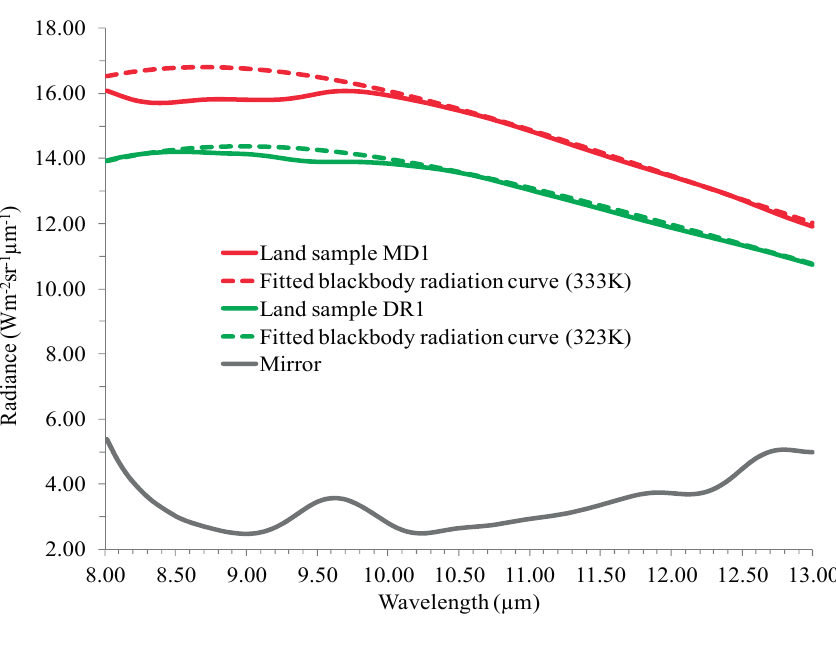
Figure 5. The at-sensor radiance with the tangent blackbody radiation curve for two land samples and the at-sensor radiance of a